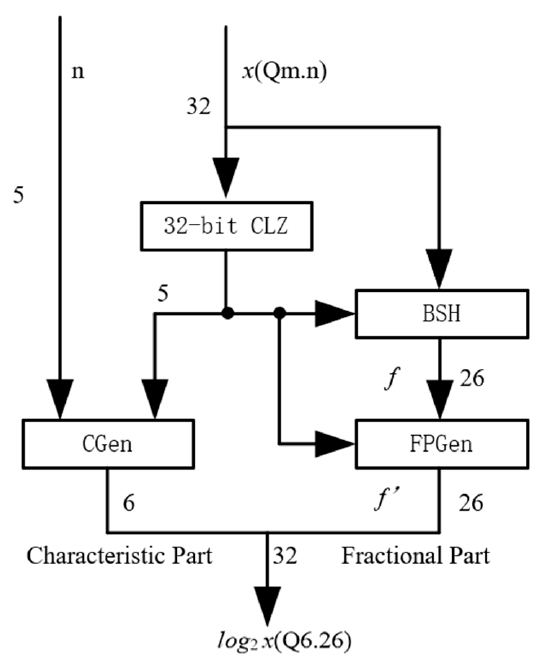
Figure 14. Architecture of logarithmic converter.